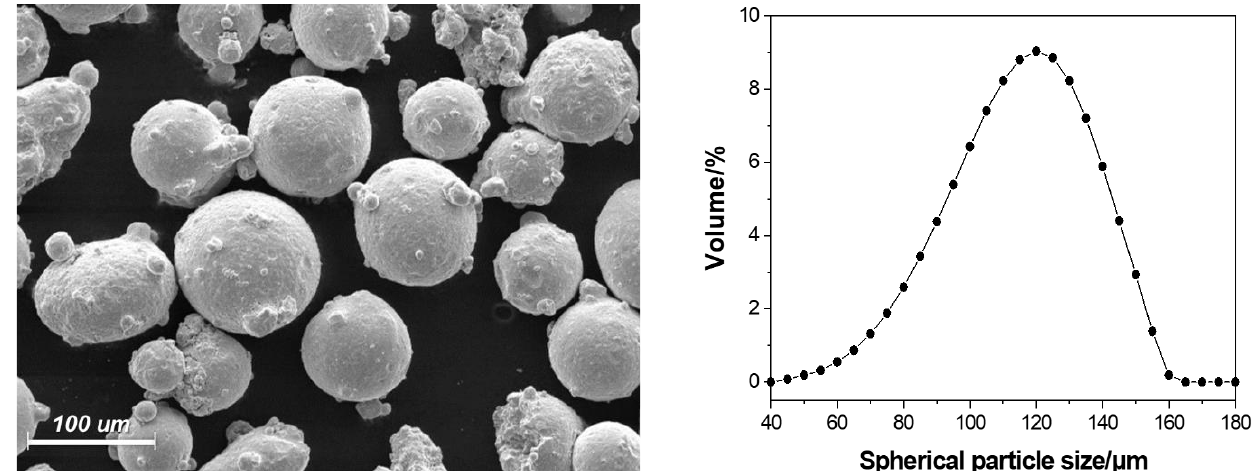
Table 1. Chemical compositions of the AISI H13 (N-H13) and HTCS-150 powders [wt.%].